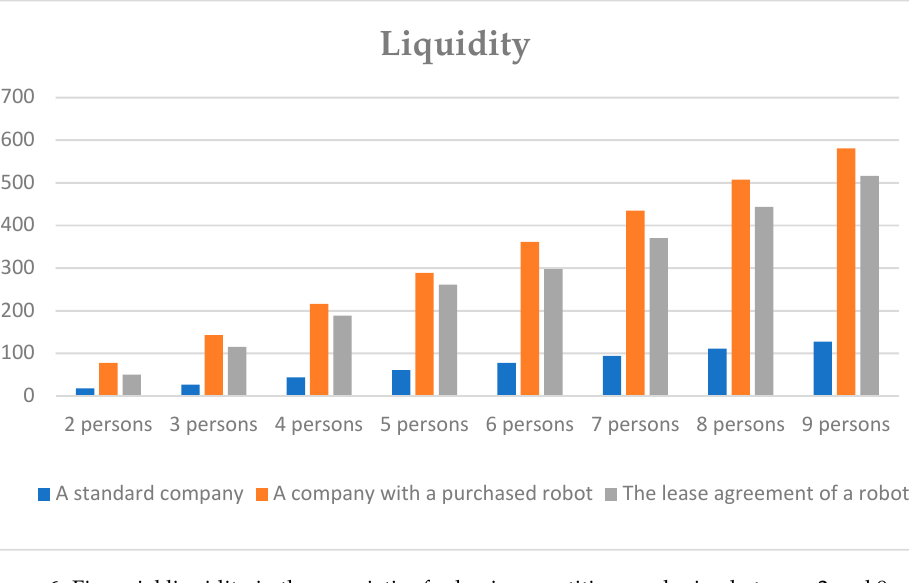
Figure 5. The debt of the business entity in three varieties for businesses employing between 2 and 9 people. The taxes do not include the tax on robotification. The red horizontal line equals a safe level of debt for the simulated enterprise.